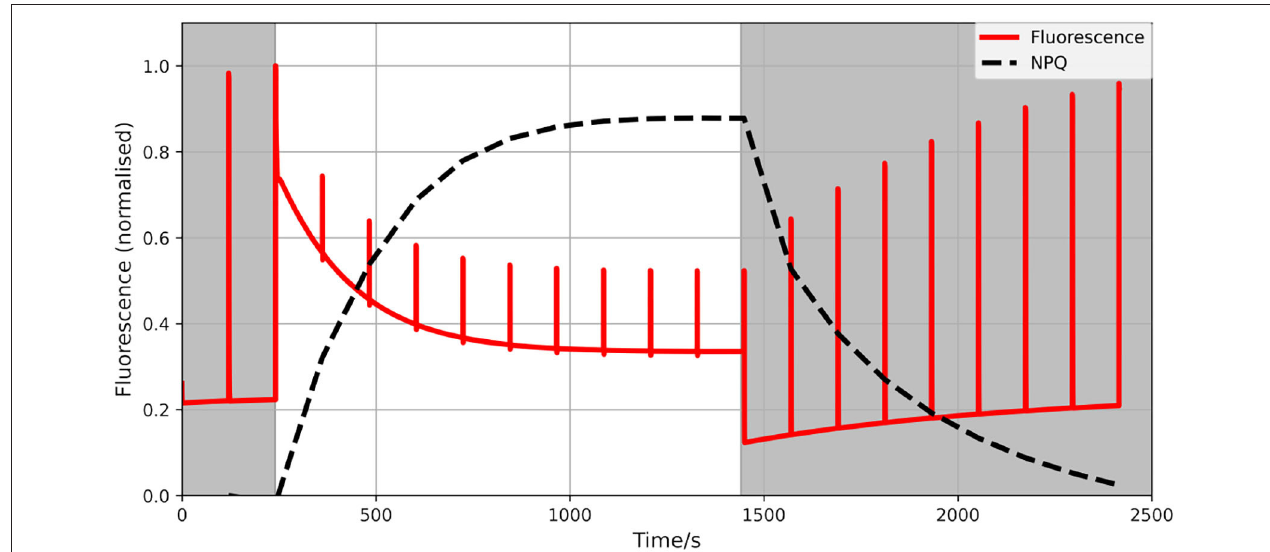
FIGURE 2 | Calculated fluorescence trace (red) of a PAM experiment of a generic photosynthetic organism without CEF. A standard dark-light-dark protocol was simulated (dark phase shaded). We used 1,000 µ molm − 2 s − 1 photosynthetic photon flux density (PPFD) as the intensity of the actinic light and 40 µ molm − 2 s − 1 PPFD for dark/dimmed light with pulses every 2 min. The calculated NPQ is marked in black (dashed). It exhibits well-known dynamics of excitation and relaxation.